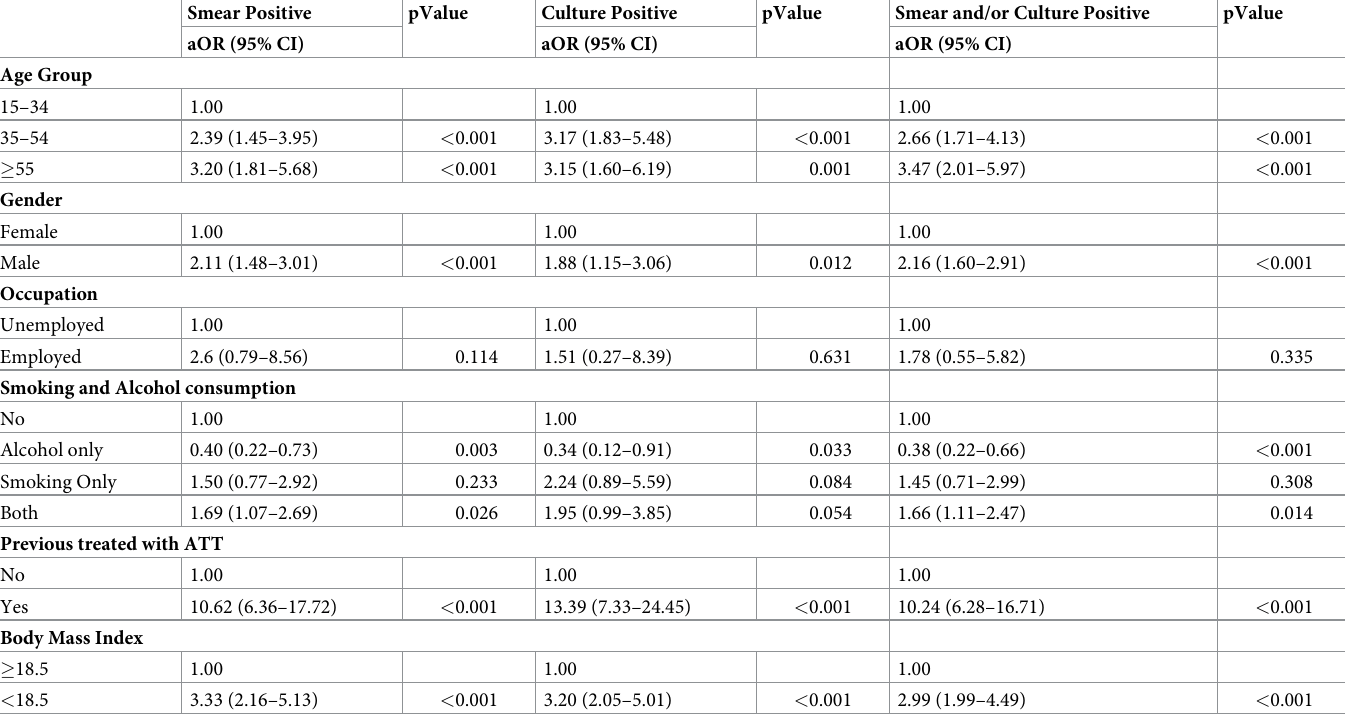
Table 3. Multivariate analysis for the factors associated with the occurrence of pulmonary